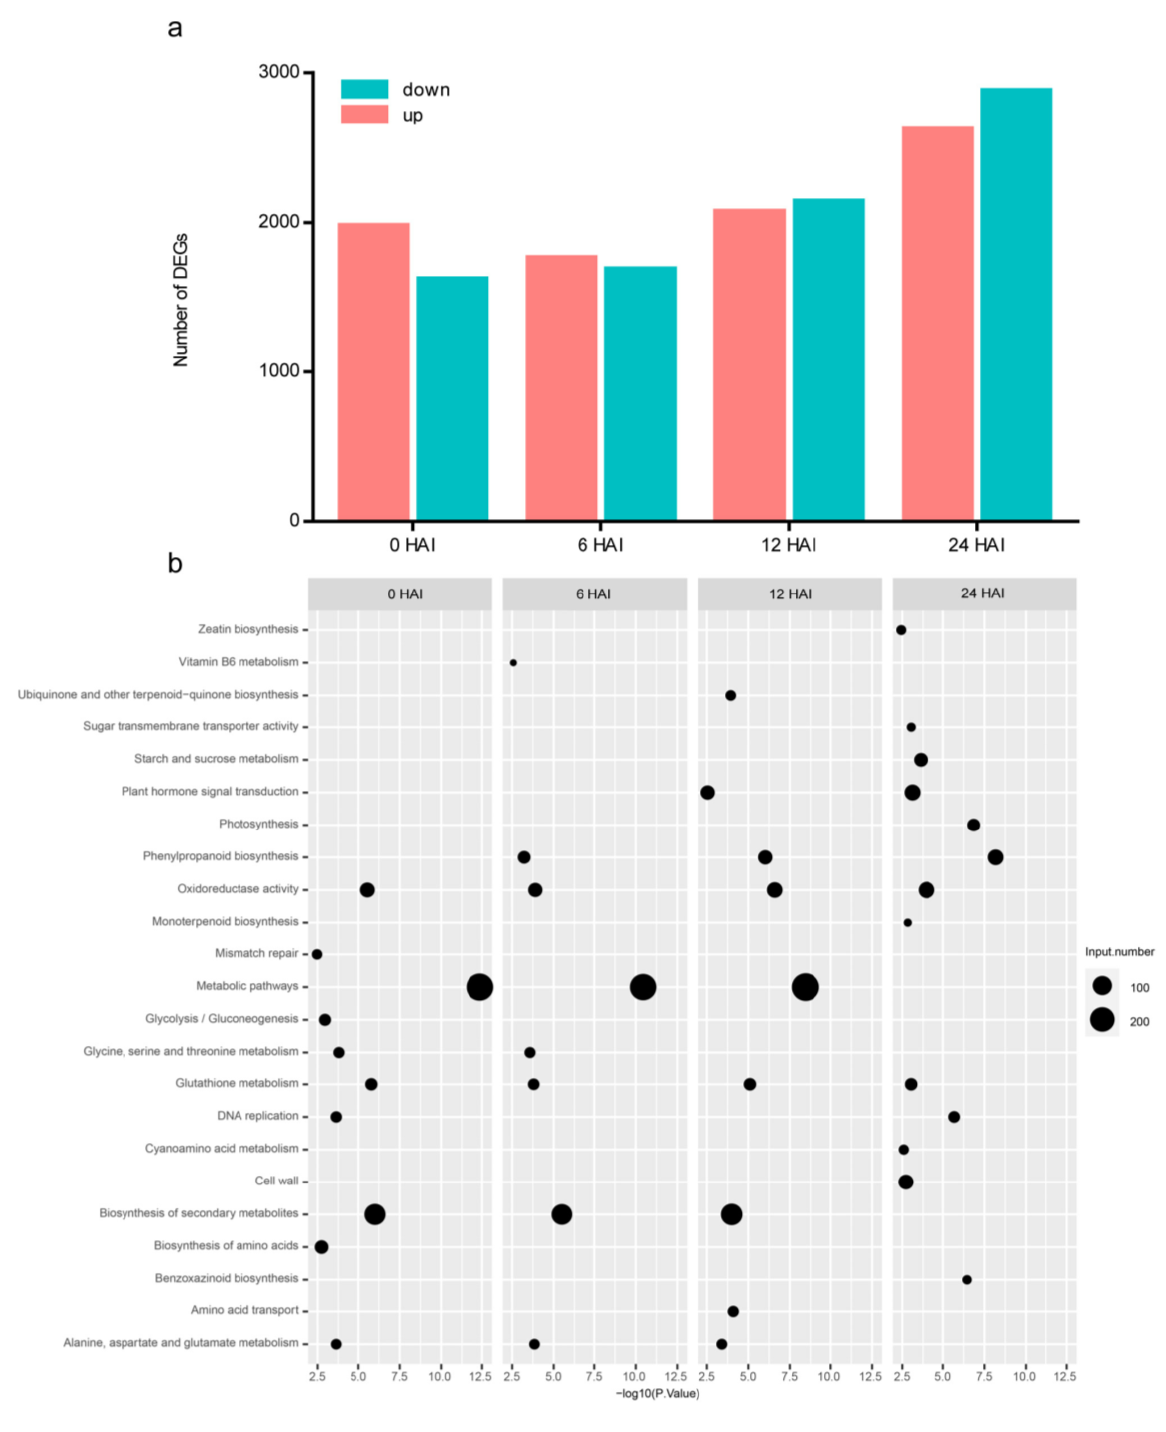
Figure 3. Transcriptome comparisons between 72-3 and F9721 during seed germination. ( a ) The number of DEGs between 72-3 and F9721 at the indicated stages. ( b ) KEGG analysis of DEGs between 72-3 and F9721 at indicated stages.